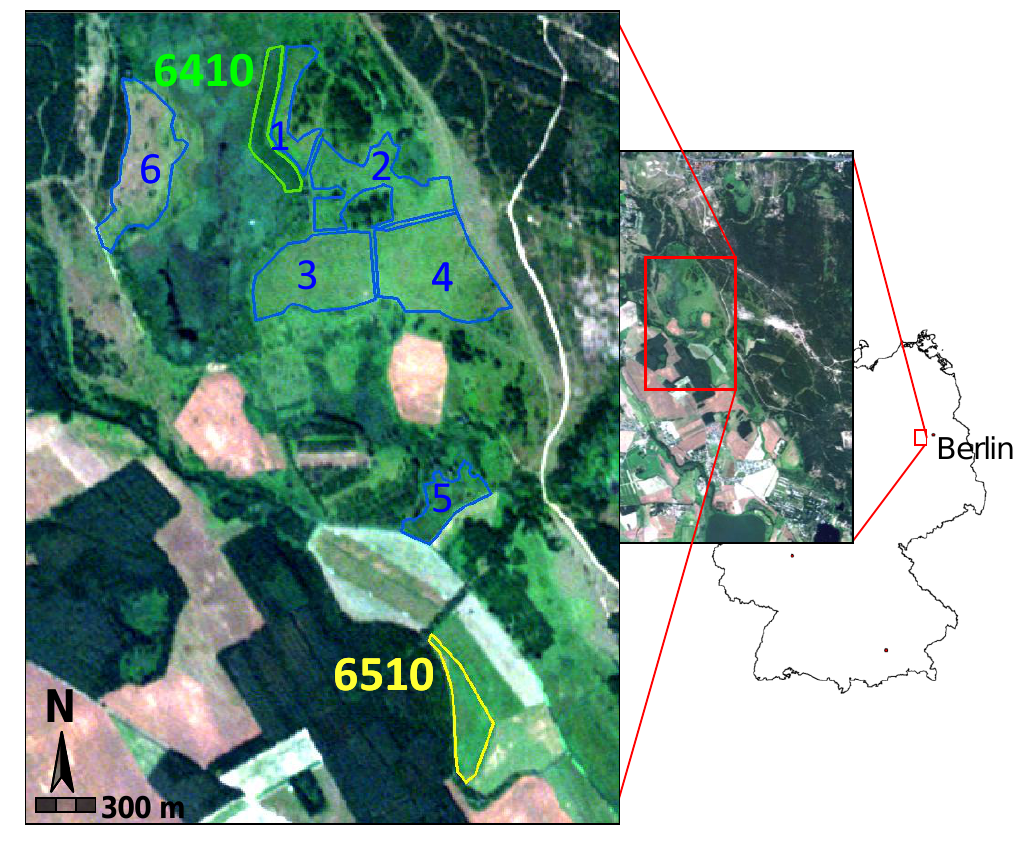
Figure 1. The study sites in the semi-natural grassland section of the research area (RapidEye image from 27 July 2009): Molinea meadow (6410) in green, extensively managed hay meadow (6510) in yellow and pasture in